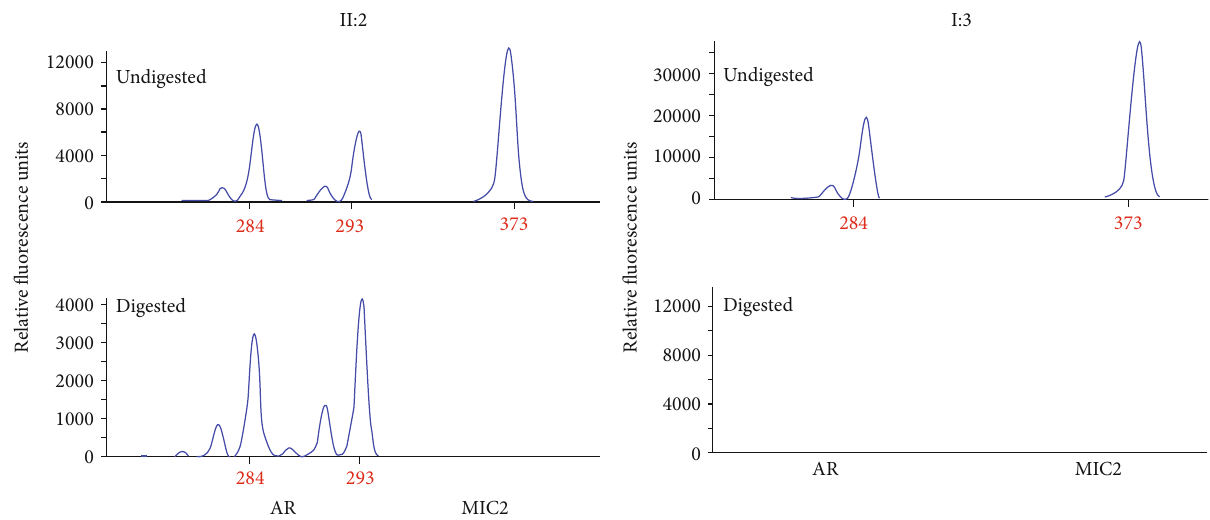
Figure 5: Skewing of the X inactivation analysis. The HUMARA assay was performed on genomic DNA extracted from the heterozygous female patient (II:2) and her father ’ s (I:3) peripheral blood. The DNA was digested with and without a methylation-sensitive restriction enzyme (HpaII), ampli fi ed by PCR using FAM-labelled primers speci fi c to the HUMARA locus, and analysed by capillary